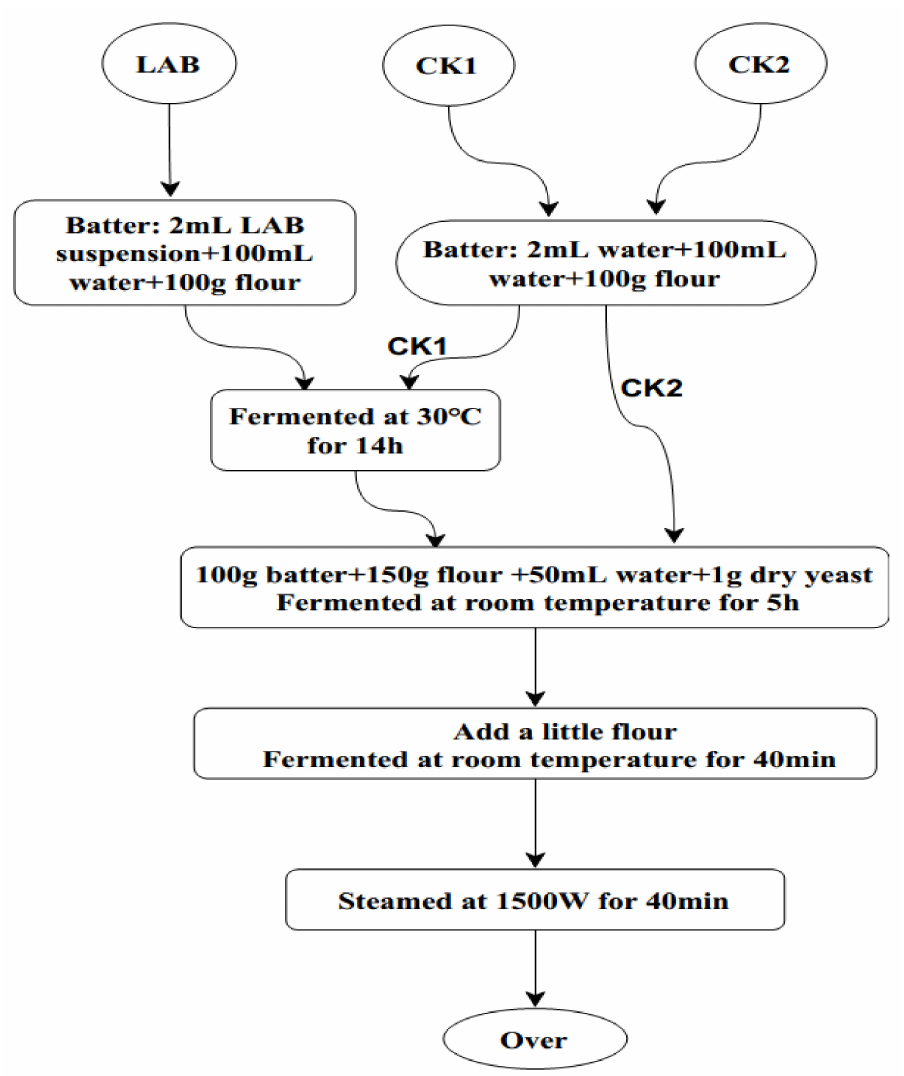
Figure 1. Steps to produce CSB with or without LAB. CSB, Chinese steamed buns; LAB, lactic acid bacteria, Batter: 2 mL ZZUA493 suspension + 100 mL water + 100 g flour fermented at 30 ◦ C for 14 h; CK1, Batter: 2 mL water + 100 mL water + 100 g flour fermented at 30 ◦ C for 14 h control; CK2, Batter: 2 mL water + 100 mL water + 100 g flour unfermented